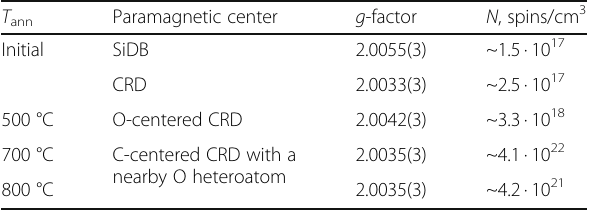
Table 1 Parameters of EPR signals observed in the initial and annealed SiO 2 :C samples at 292